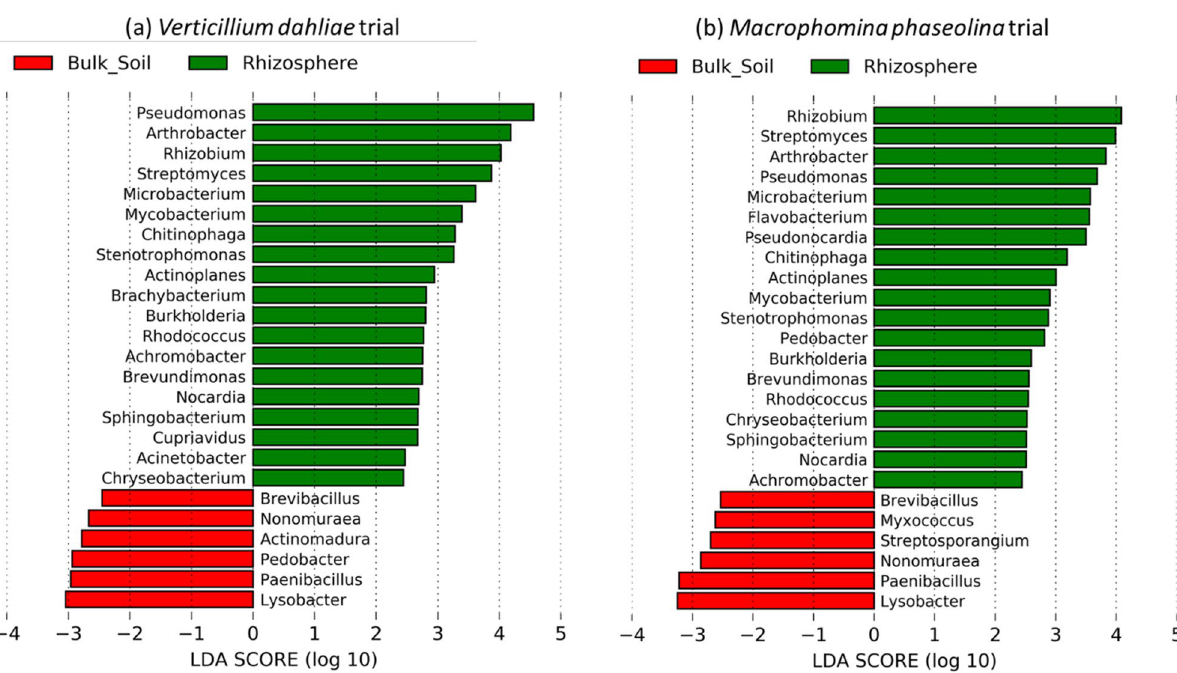
Figure 4. Linear discriminant analysis (LDA) effect size (LEfSe) of genera known to include species antagonistic to filamentous fungal pathogen in the rhizosphere and bulk soil of strawberry grown in fields infested with Verticilium dahliae and inoculated with Macrophomina phaseolina . Genera listed were both significantly different (α = 0.05) and had an LEfSe score of > 2.0. A positive LDA score represents depletion in bulk soil and enrichment in rhizosphere (green) and a negative LDA score represents the opposite